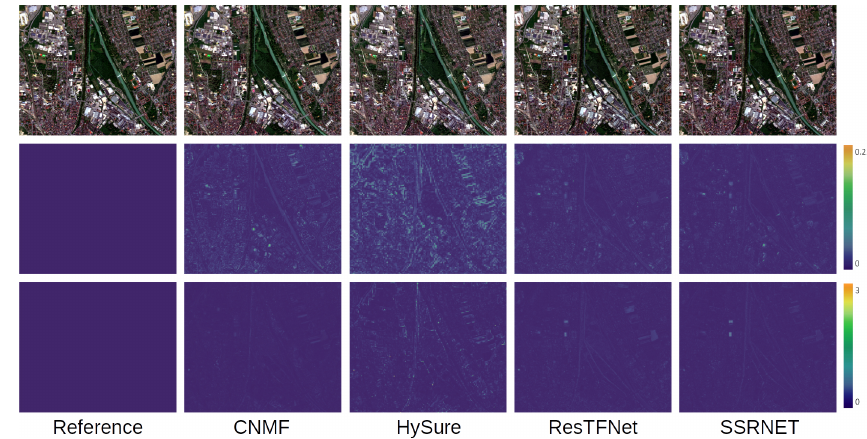
Figure 10. Visualizations of super-resolution results. The first row demonstrates RGB images composed of bands of 652, 553, and 450nm. The second row demonstrates the rooted squared error between the reference and fusion results. The third row demonstrates the angle differences between the reference and fusion results.